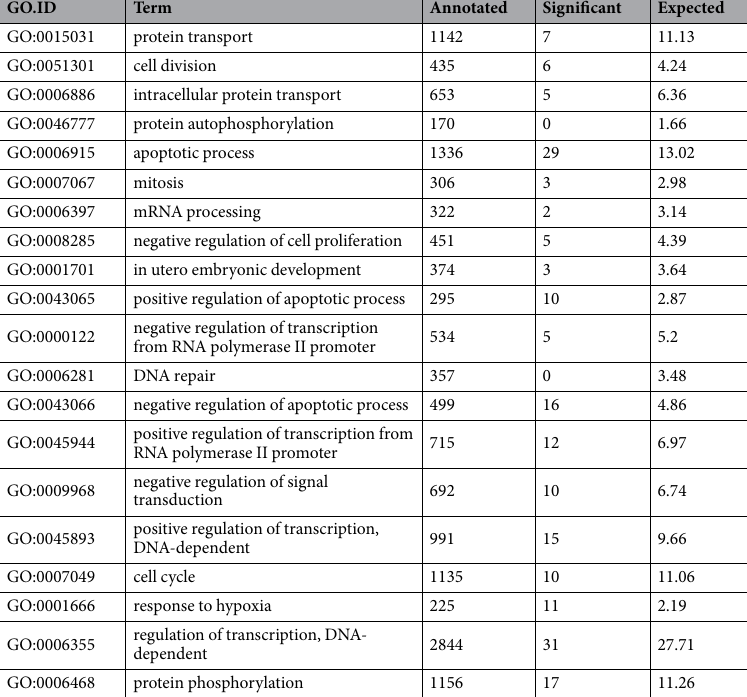
Table 2. The significant GO terms for the genes found to be differentially expressed between treatmentA (wt) and treatmentB (ko) their corresponding annotation for Biological Function (BF). Annotated: Number of genes associated to the GO term, Significant: Number of significantly differentially expressed (p <= 0.05) genes within the annotated genes, Expected: Number of genes within the annotated genes that are expected to be significantly deferentially expressed (p < = 0.05) by